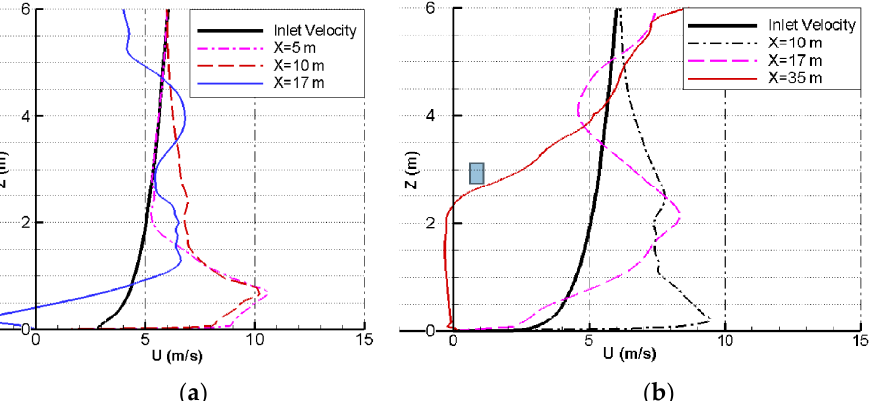
Figure 2. Subfigures ( a ) & ( b ) show the vertical profile of the airflow’s changing longitudinal velocity at different longitudinal positions relative to the inlet location. Subfigure ( a ) shows airflow aligned with the building’s center line. Subfigure ( b ) shows airflow passing 9 m on either side of center line [33] (p. 10).